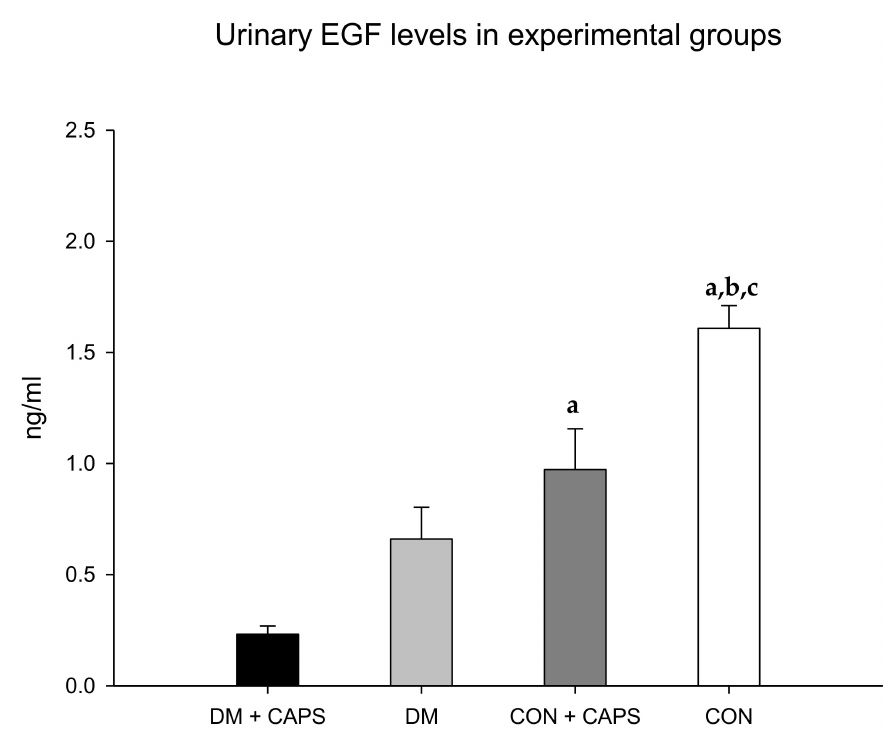
Figure 7. Effect of 8 weeks of capsaicin administration (1 mg/kg/day) on urinary EGF levels. ( a ) Statistically significant difference in comparison with the DM group + CAPS; ( b ) statistically significant difference in comparison with the DM group; ( c ) statistically significant difference in comparison with the CON group + CAPS. EGF: epidermal growth factor. Data are mean ±